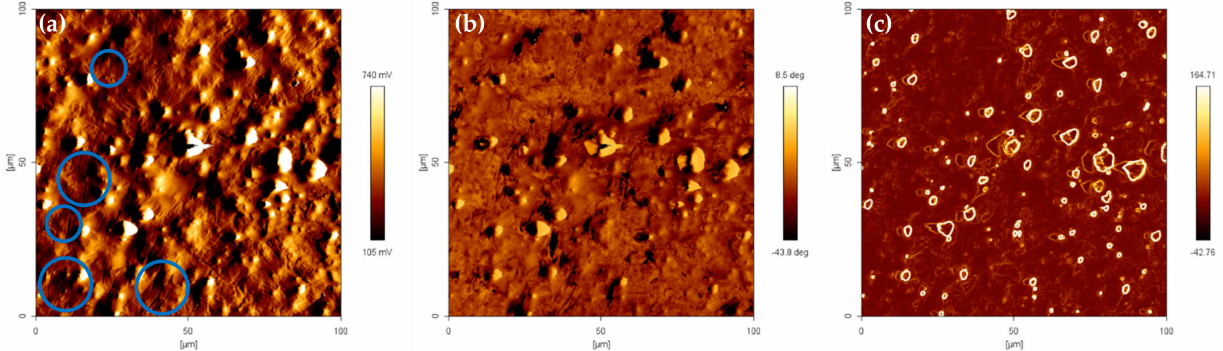
Figure 2. AFM images of over 100 µ m scan area of oscillatory sheared MRE at 115,000 cycles obtained by tapping method, ( a ) amplitude channel, ( b ) phase channel, and ( c ) phase channel with edge